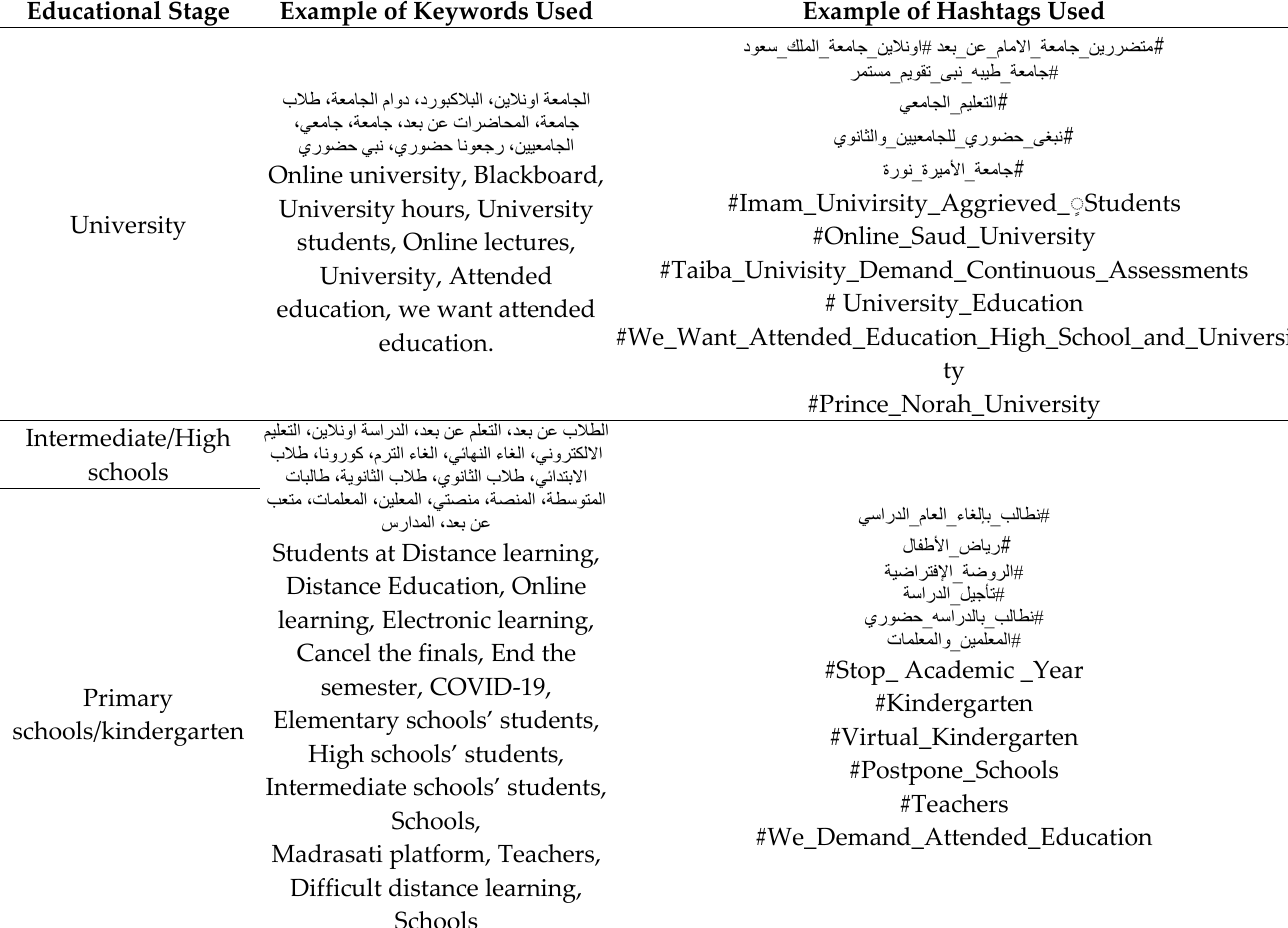
Table 2. Samples of the keywords and hashtags used for data collection.